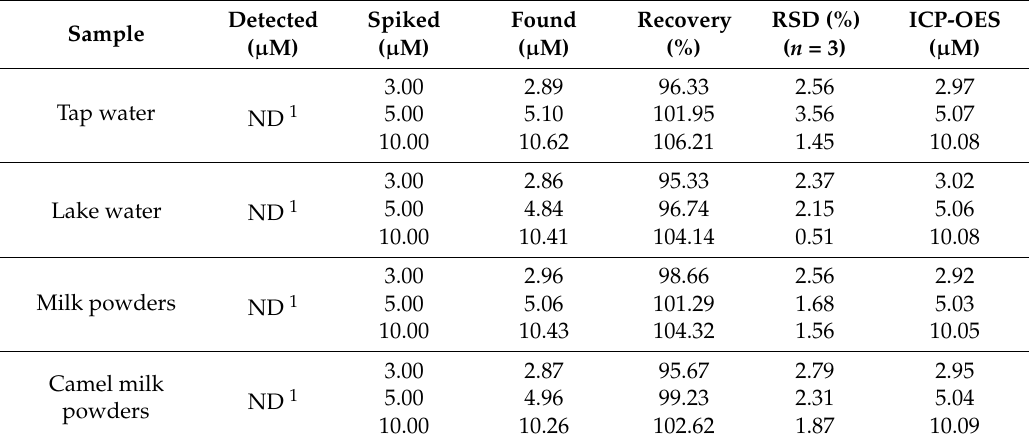
Table 1. Analytical results for Cd 2+ sensing in real samples.